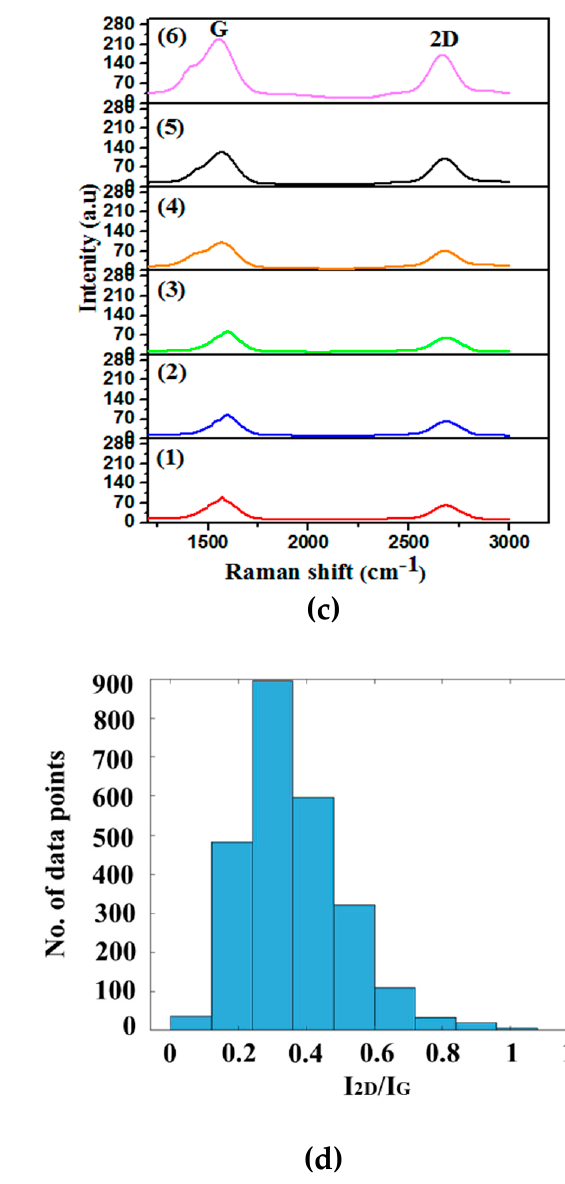
Figure 4. G and 2D bands Raman mapping with a histogram of the I 2D /I G ratios of P10% sample. Figure 4. (a,b) G and 2D bands Raman mapping, (c) Raman spectra, and (d) histogram of the I 2D /I G ratios of P10% sample. The Raman intensity mapping at various points for the G and 2D are presented in Figure 4. The G and second order 2D bands rise from the green and navy-blue boundaries. Both bands have brighter areas and defect zones. The I 2D /I G intensity ratio indicated the layer numbers of the graphene sheets, which are obtained from the Raman mapping. The I 2D /I G intensity ratios were around 78% for points (1)–(4), 0.45 to 0.51. However, for points (5) and (6), the I 2D /I G values were 0.68 and 0.77, respectively, which was remarkably high and indicated that the FLG formed. The histogram results also correlated with the I 2D /I G ratios exposed in Figure 4